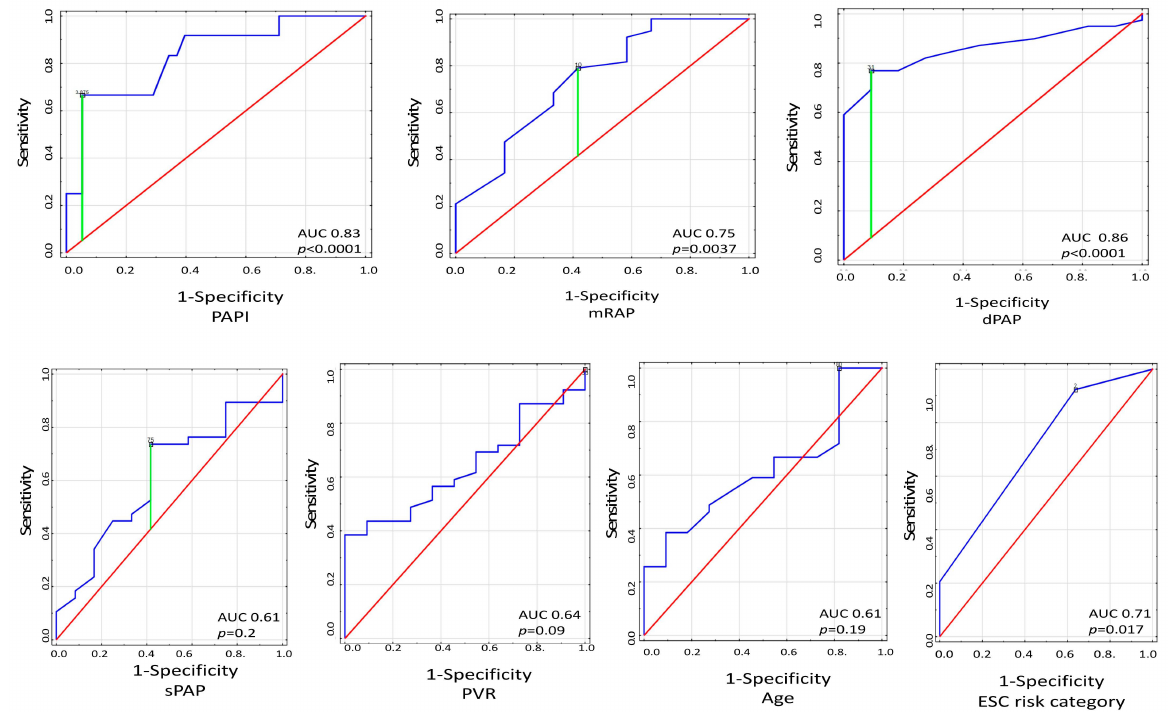
Figure 3. Receiver-operating characteristics curves for the ability of PAPI, mRAP, sPAP, dPAP, ESC risk model, and age to predict mortality risk. Red line represents reference line. Abbreviations: dPAP, diastolic pulmonary arterial pressure; ESC, European Society of Cardiology; mRAP, mean right atrial pressure; PAPI, pulmonary artery pulsatility index; PVR, pulmonary vascular resistance; sPAP, systolic pulmonary arterial